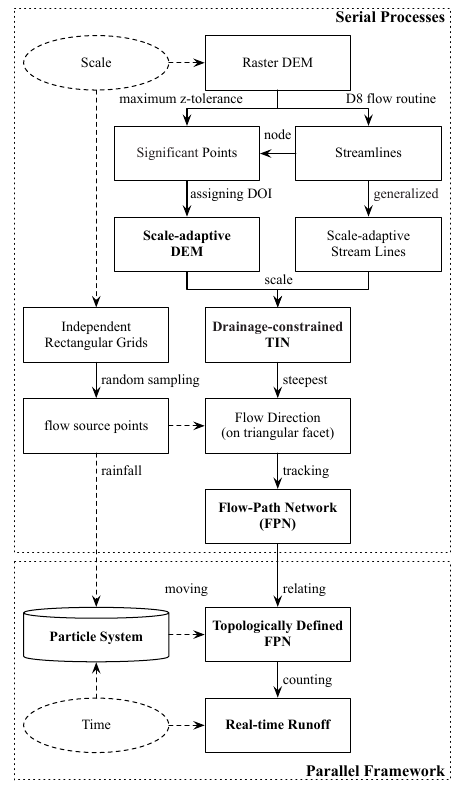
Figure 1: The overall framework for high-performance surface rainfall-runoff modeling and